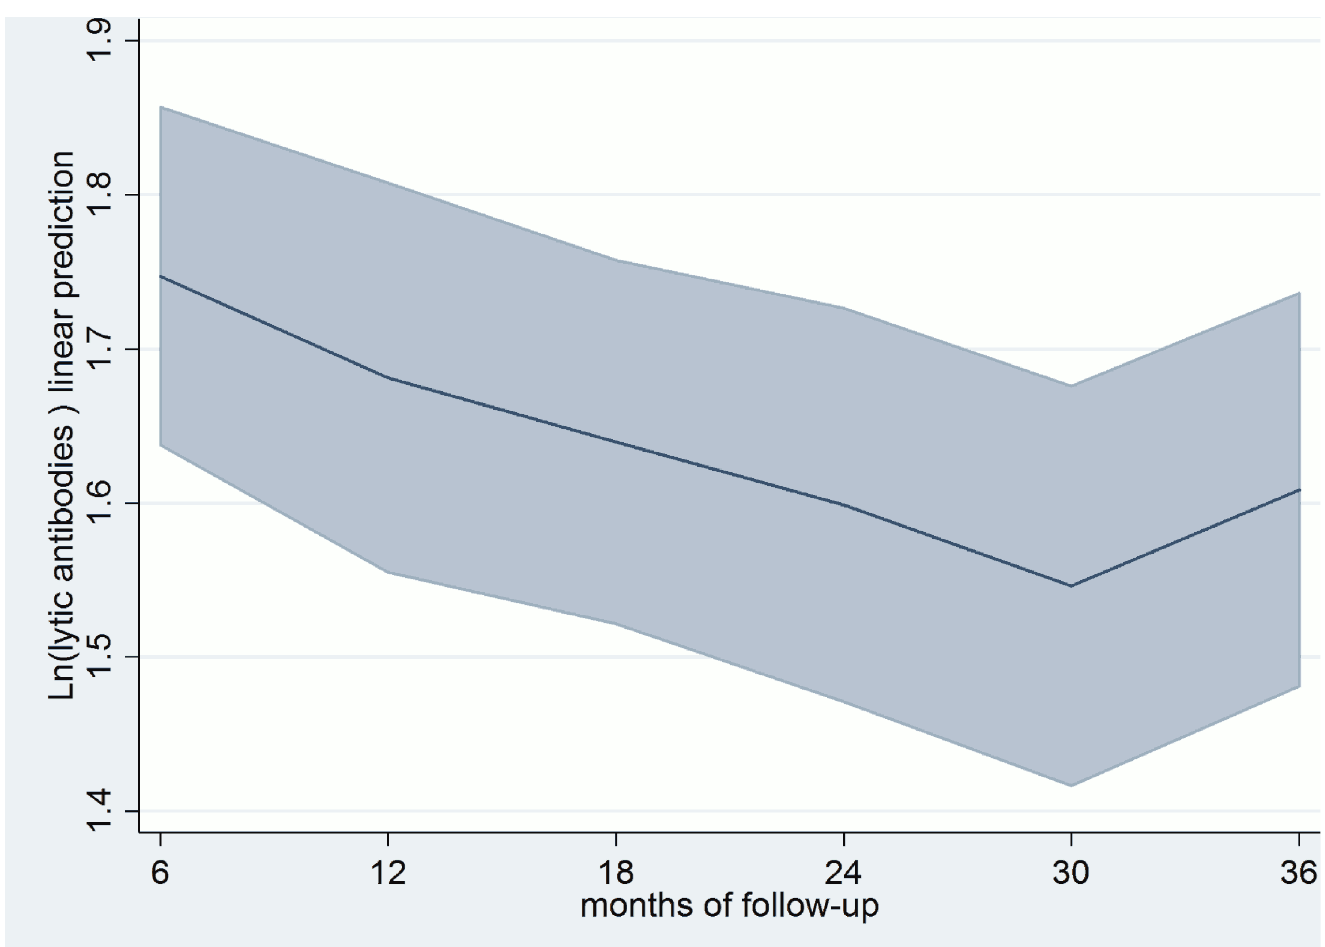
Fig 2. Variations in AT CL-ELISA levels. Months of follow-up predictive margins with 95% CI. Cutoff AT CL ELISA =